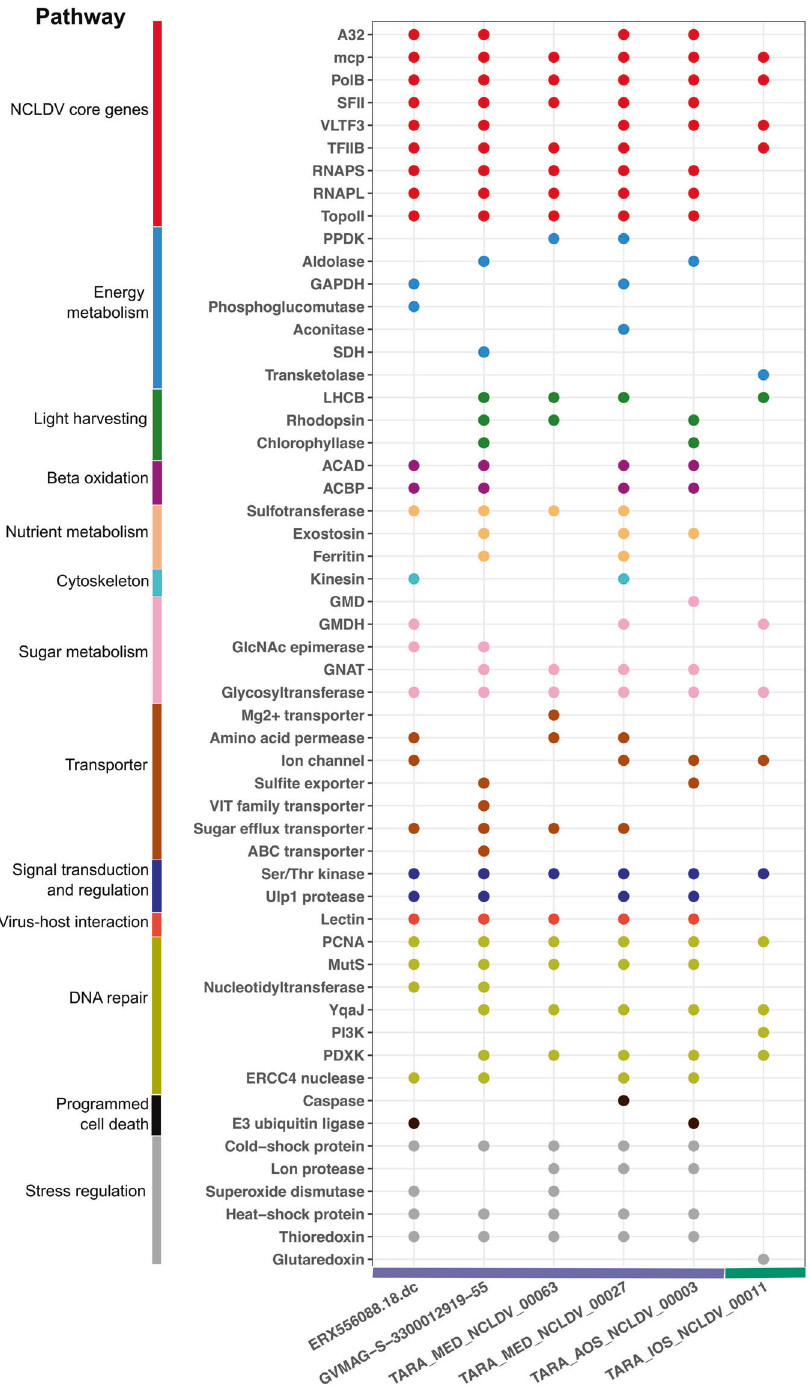
Fig. 8 Functions encoded in the genomes of the six viruses that are widespread in oligotrophic waters. On the x-axis, genomes are ranked from left to right in order of decreasing number of samples in which the viruses were detected; the horizontal colored bar shows the taxonomic family of the genome (purple: Imitervirales family 1, green: Algavirales family 1). The y-axis denotes the functional annotation found in genomes; putative genes are color-coded by functional categories. Gene function abbreviations: PPDK Pyruvate phosphate dikinase, GAPDH Glyceraldehyde 3-P dehydrogenase, SDH Succinate dehydrogenase, LHCB Chlorophyll a/b binding protein, ACAD Acyl-CoA dehydrogenase, ACBP Acyl-CoA binding protein, GMD GDP-mannose dehydrogenase, GMDH GDP-mannose 4,6 dehydratase, GlcNAc epimerase UDP-N-acetylglucosamine 2-epimerase, GNAT Glucosamine-6-phosphate N-acetyltransferase, PCNA Proliferating cell nuclear antigen, PI3K phosphatidylinositol 3-kinases, PDXK PD-(D/E)XK nuclease superfamily.